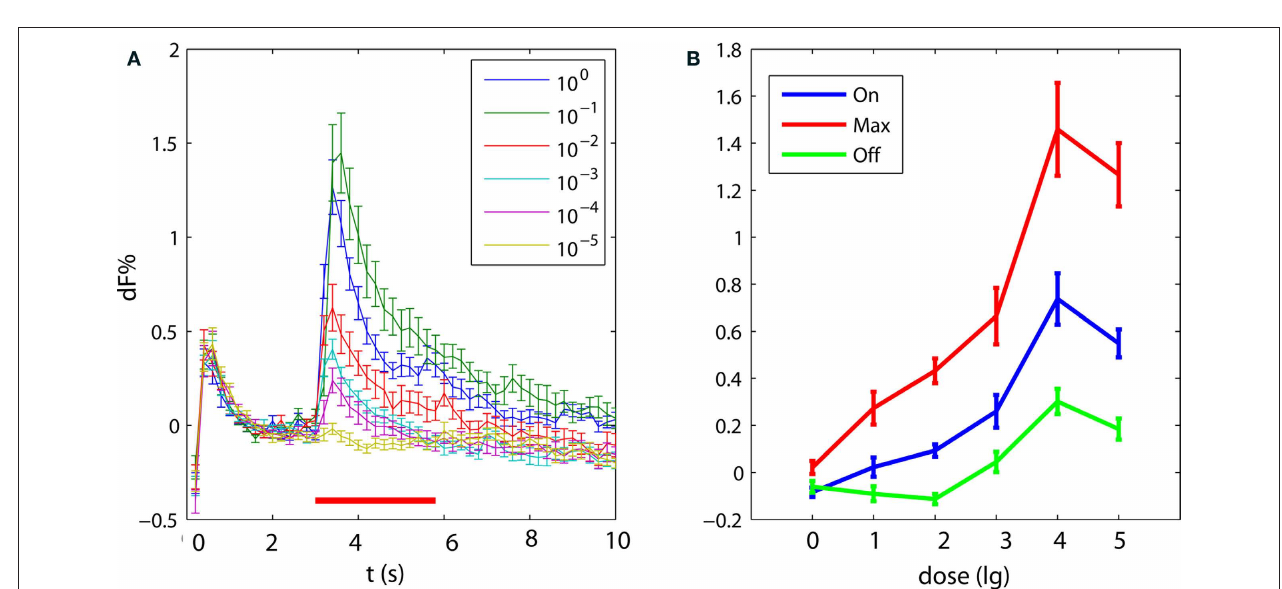
FiGure 3 | response strength of PCT neurons depends on odor concentration. (A) Temporal dynamics of averaged odor responses to stimulations with six odor concentrations of octanal (8ol, black bar: 3 s stimulus, error: SEM, n = 5). (B) Dose–response curves for mean responses to 8ol during the first second of stimulus (On), during the maximal response (Max), and during the first second after stimulus offset (Off; error: SEM, n =